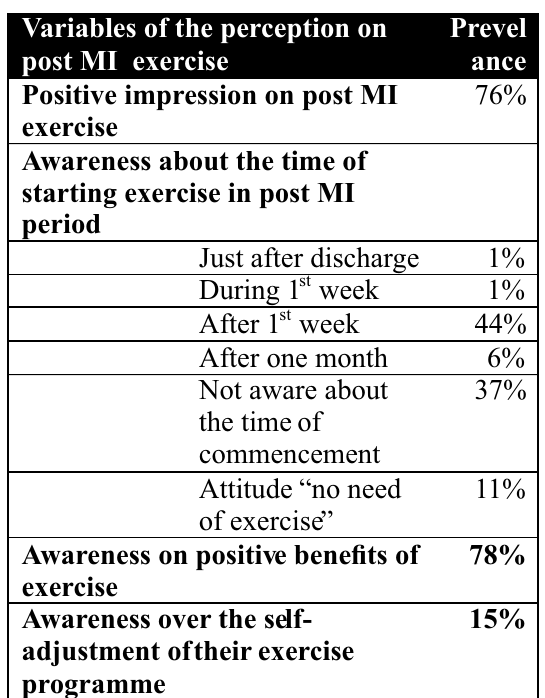
Table 03. The distribution of the different attitudes in perception of post MI